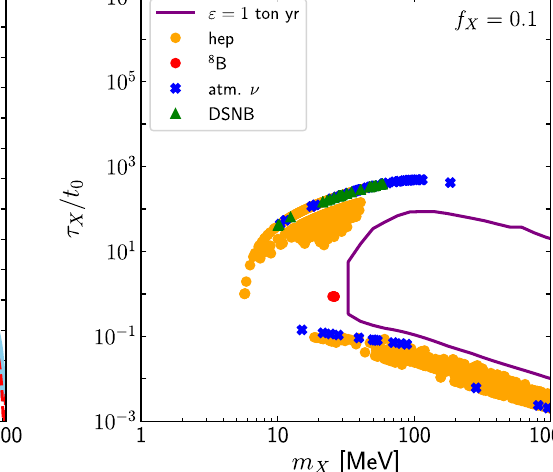
= 0 . 1 keV and thr